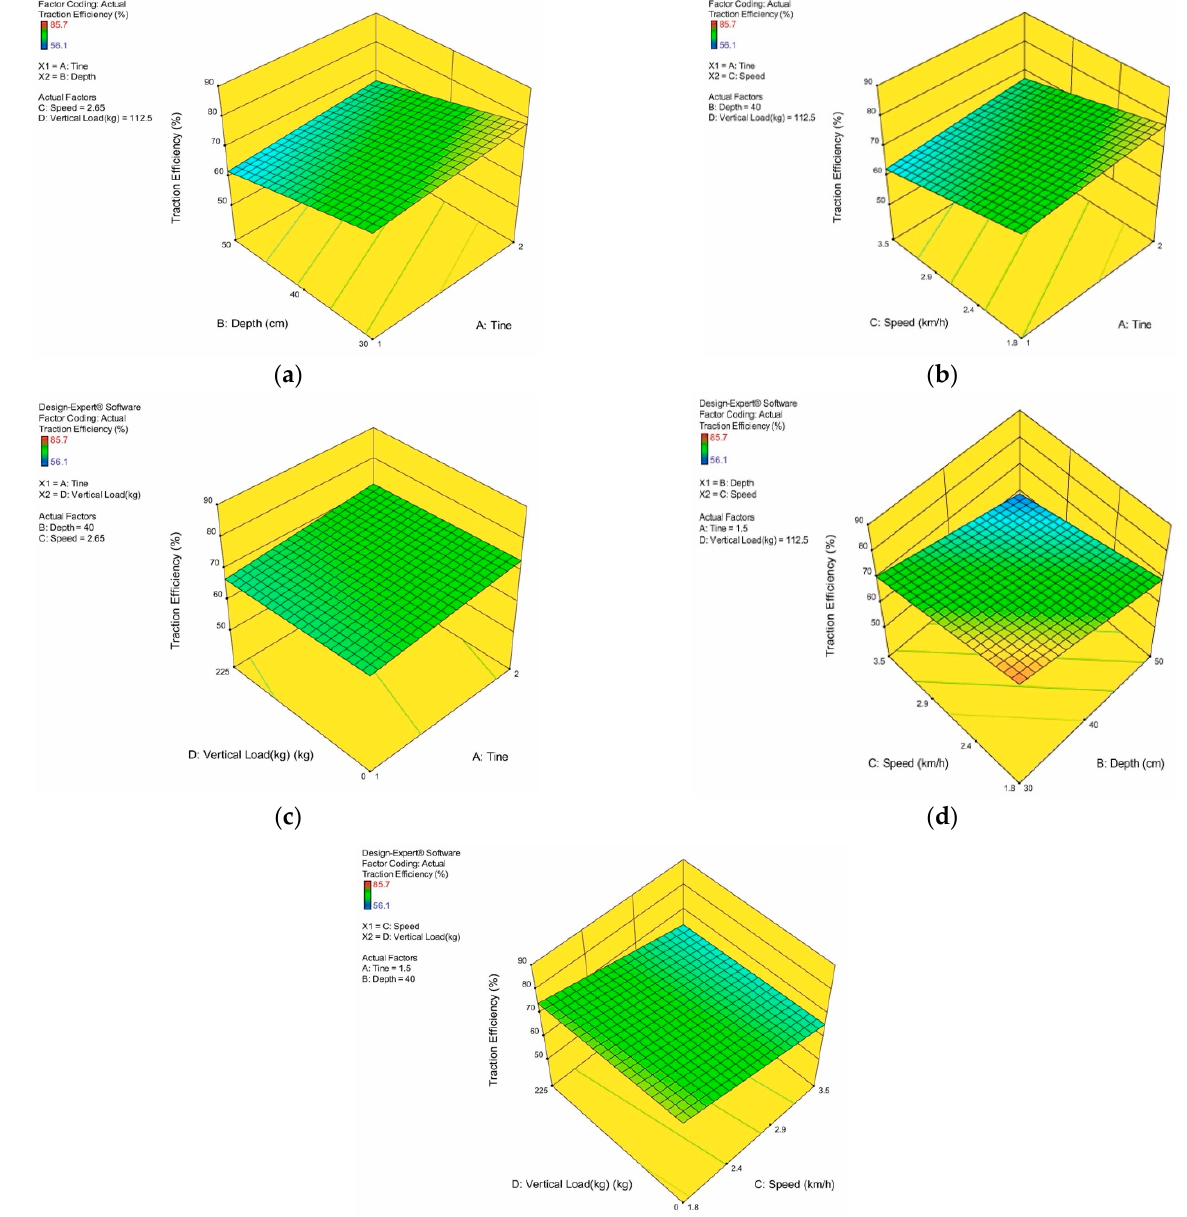
Figure 8. 3D surface curves of drawbar power as influenced by interactions between input parameters using the RSM approach; ( a ) tine and depth, ( b ) tine and speed, ( c ) tine and vertical load, ( d ) depth and speed, ( e ) depth and vertical load, ( f ) speed and vertical load.